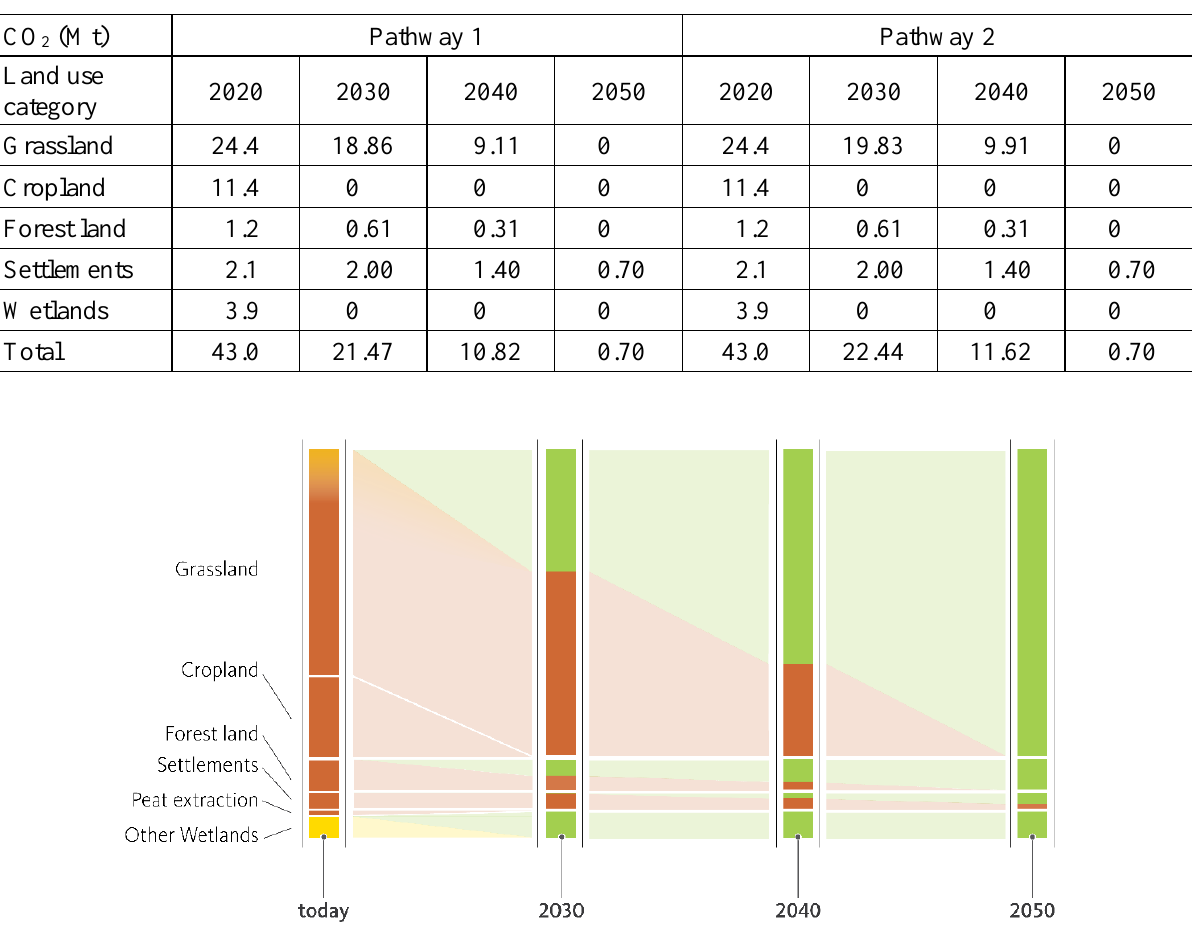
Table 2. CO 2 emissions (in Mt) from land use on organic soil in Germany under the proposed emission reduction pathways 1 and 2 (for details, see text).